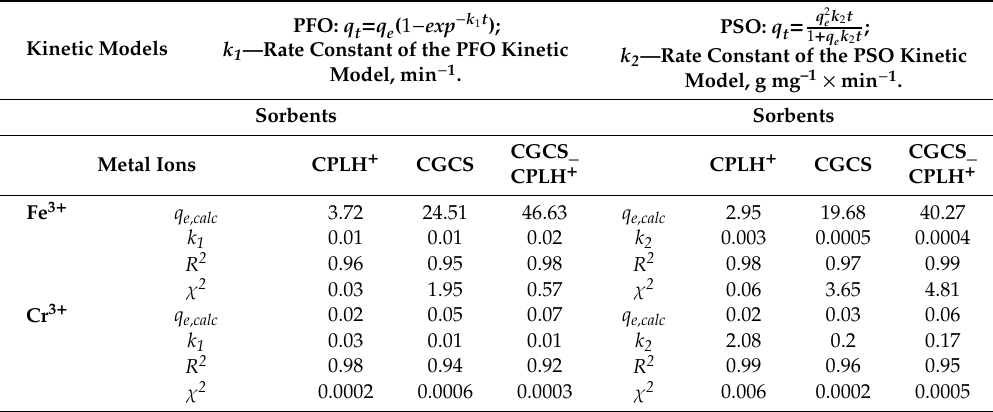
Table 2. Kinetic model parameters for the sorption of Fe 3 + and Cr 3 + metal ions onto sorbents.